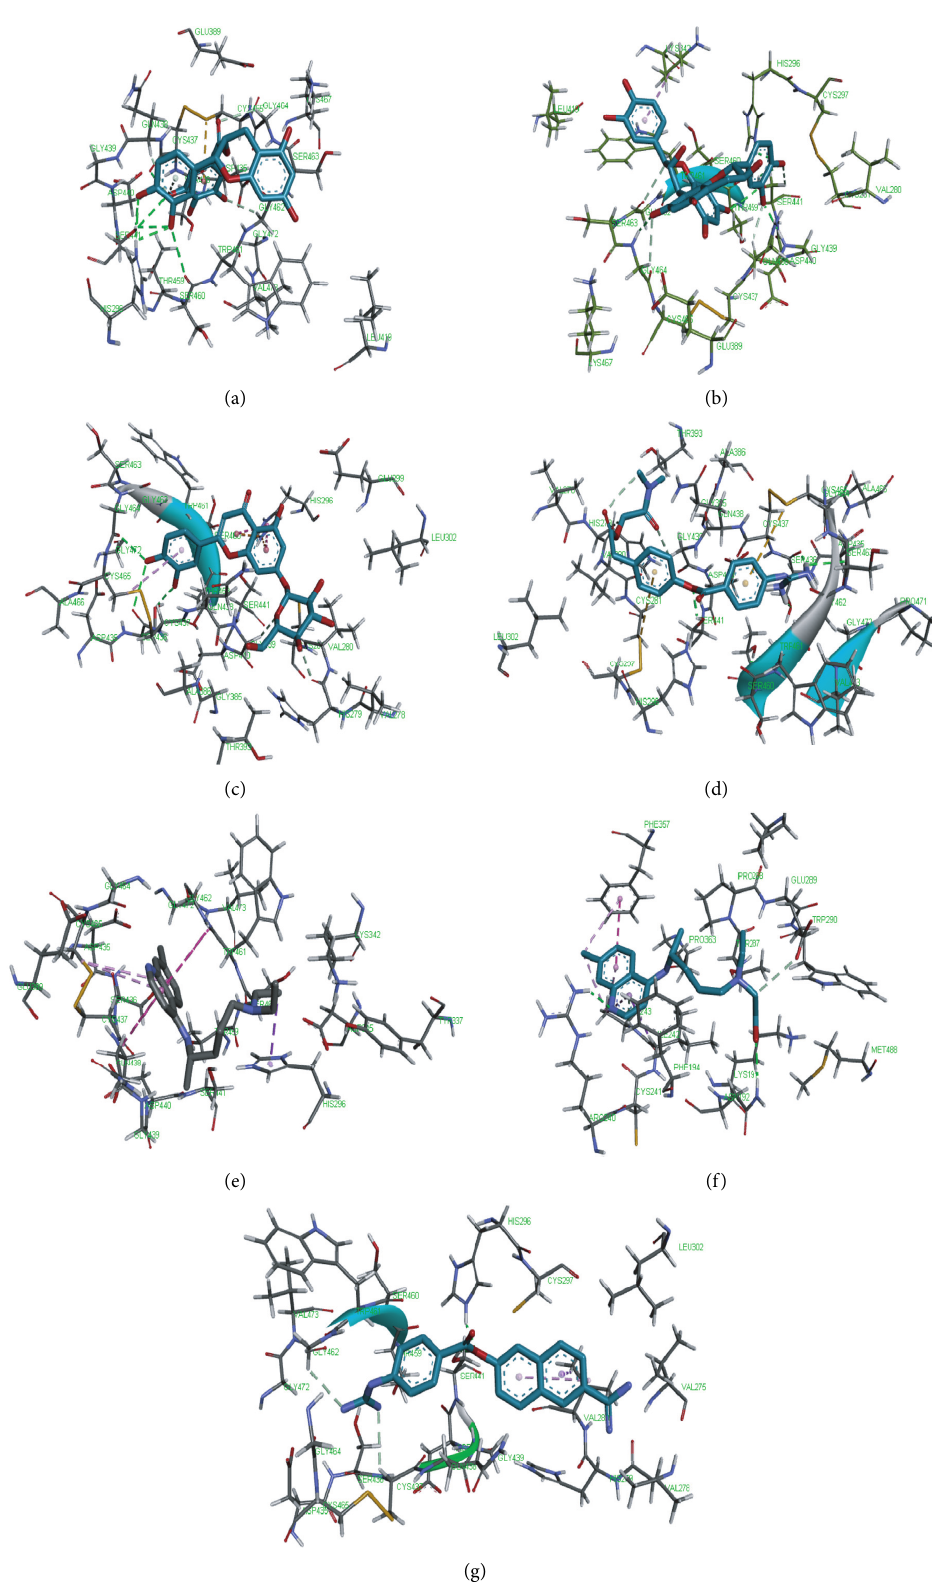
Figure 16: 3D representation of (a) 3-galloylcatechin, (b) proanthocyanidin B1, (c) luteolin 7-galactoside, (d) camostat, (e) chloroquine, (f) hydroxychloroquine, and (g) nafamostat in the binding pocket of